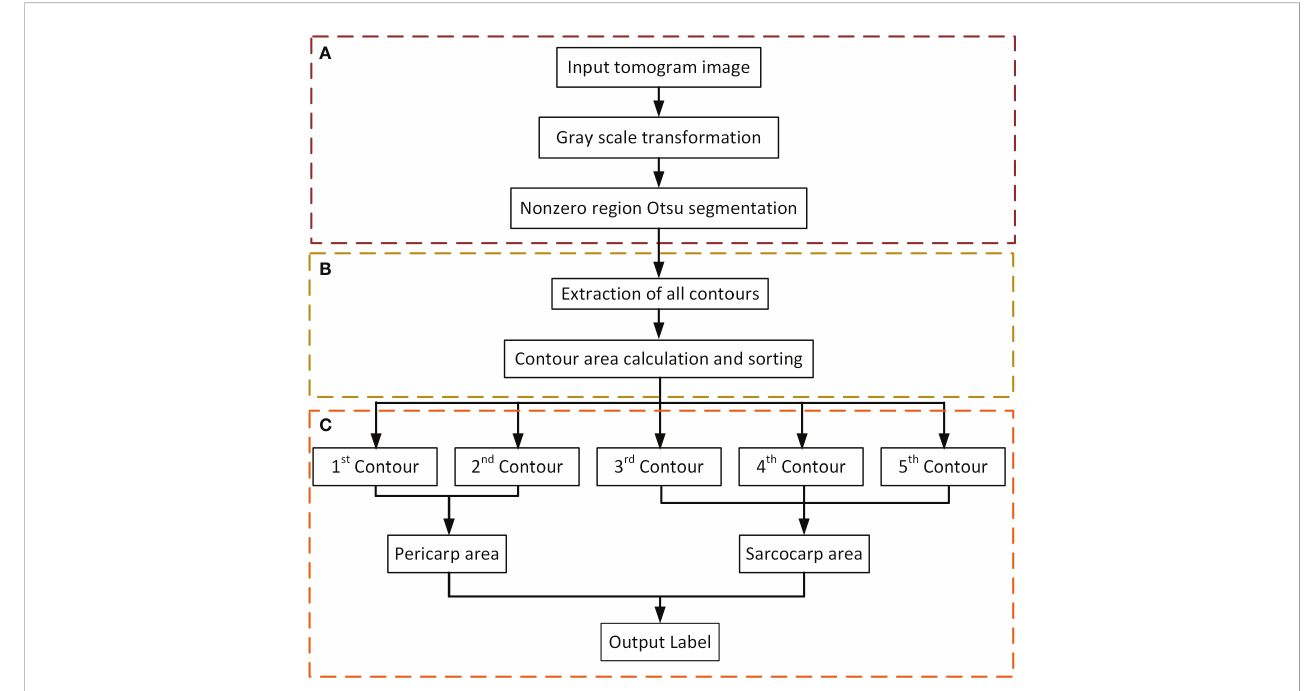
FIGURE 4 Flow of label generation method. (A) Image preprocessing. (B) Contour extraction. (C) Contour sorting and region segmentation.